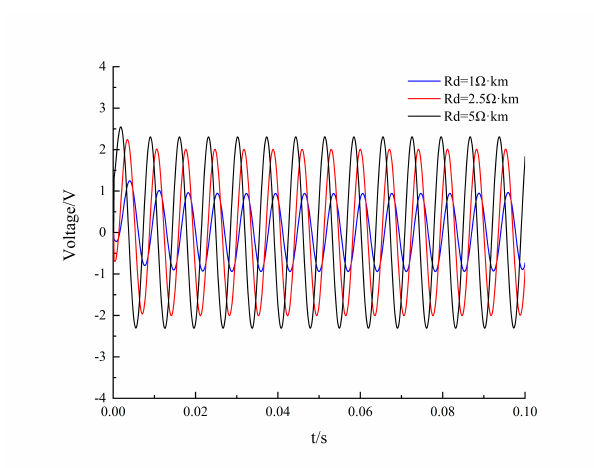
Fig. 11. Transient response of rail surface voltage at receiver end with different ballast resistance.